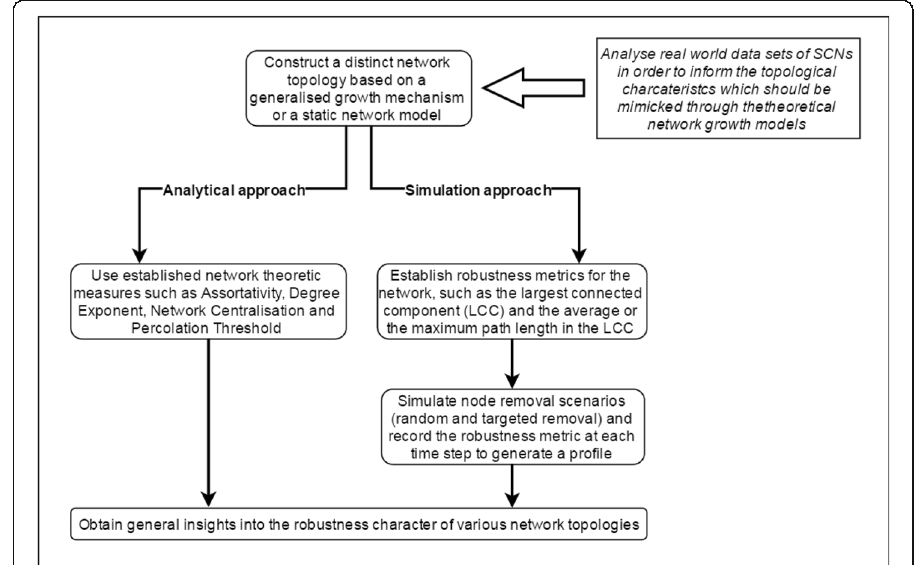
Fig. 3 General methodological framework of research on topology and robustness of